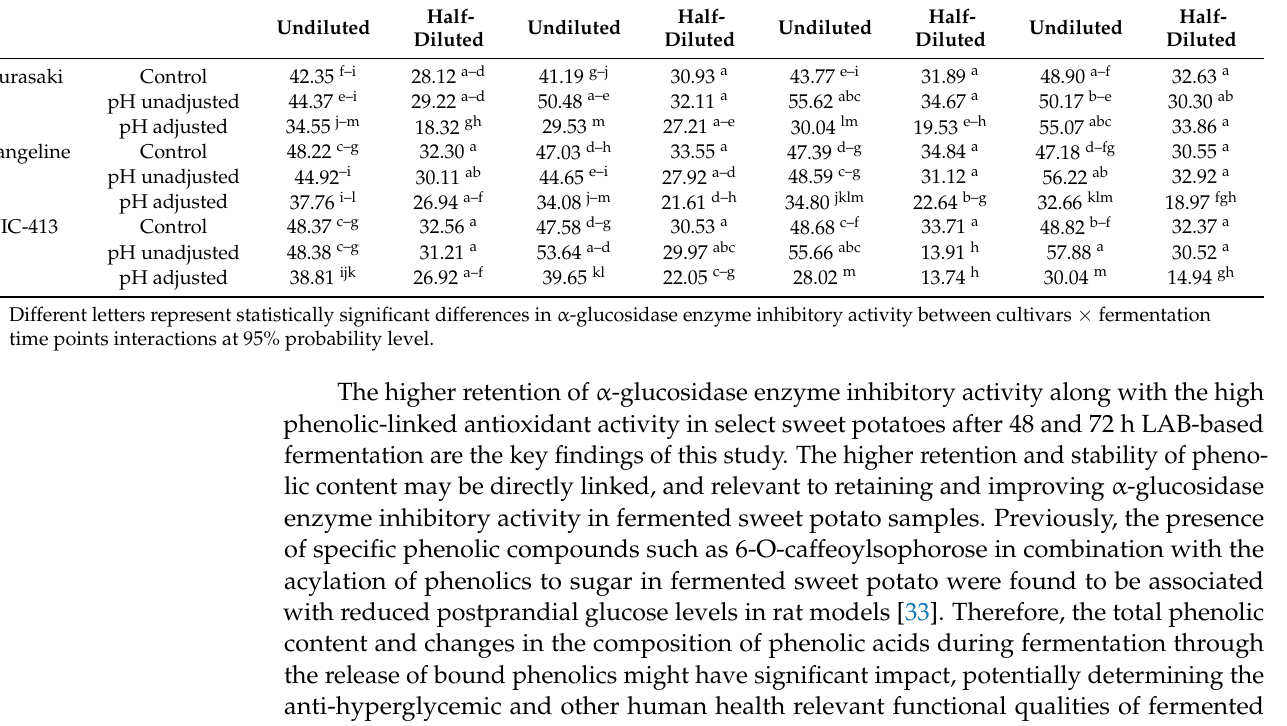
Different letters represent statistically significant differences in α -amylase enzyme inhibitory activity between fermented and unfermented sweet potato samples at a 95% probability level (separate for both dilutions) at each fermentation time point. Table 4. α -Glucosidase enzyme inhibitory (%) activity (undiluted and half diluted) of unfermented and fermented (pH adjusted and unadjusted) sweet potato samples ( n = 12) at 0, 24, 48, and 72 h fermentation time points. Sweet